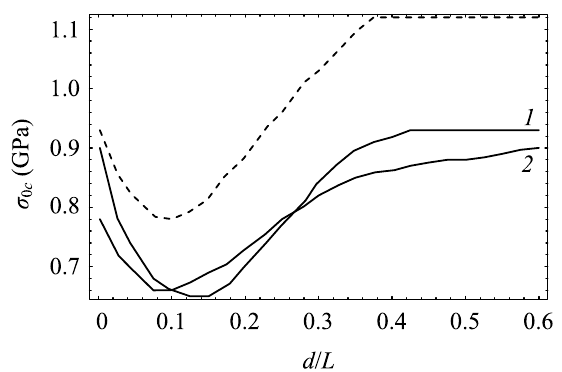
Fig. 5. Dependence of the normalized critical stress for unlimited migration of a low-angle grain bound-  0c ary in the vicinity of a crack tip on the ratio d / L of the nanoinclusion size d to the grain boundary length L calculated for  = 5 ° , l = L , and angles  = -45 ° cr and 45° (curves 1 and 2, respectively). Dashed curve illustrate critical stress  in the absence of a crack 0c (calculated after Ref. [32